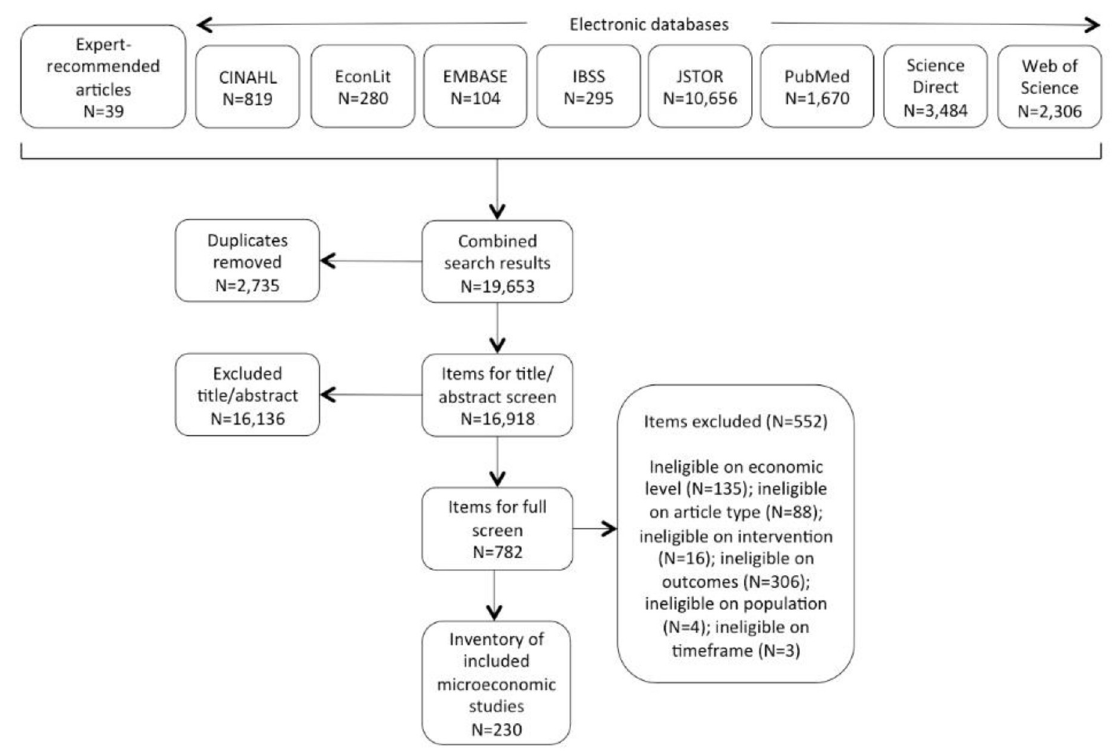
Fig 1. Screening